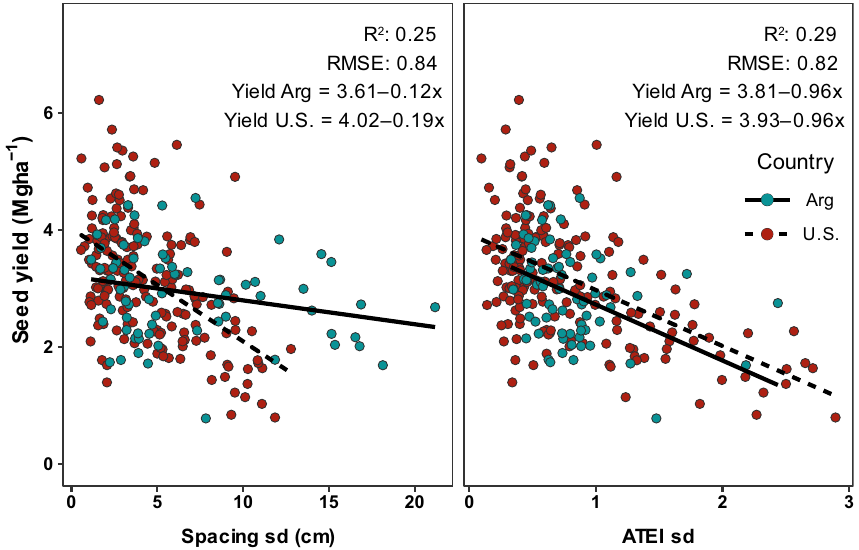
Figure 3. Relationship of spacing standard deviation (Spacing sd, cm) and achieved versus targeted evenness index standard deviation (ATEI sd) to soybean yield. Different colors and line types denote different countries (Argentina, Arg—full line, red points; United States, US—dashed line, blue points). R 2 coefficient of determination, RMSE root mean square